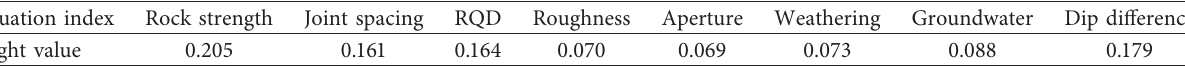
Table 7: Weight values for the evaluation index of rock mass quality.